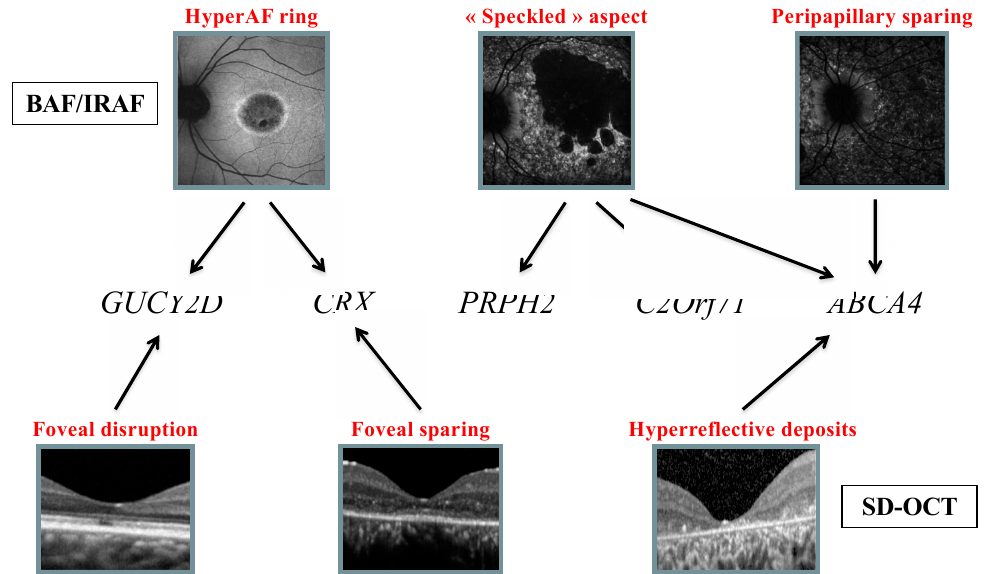
Figure 5. Decision tree showing clinical features of FAF and SD-OCT that may help to identify the causative genetic defect.